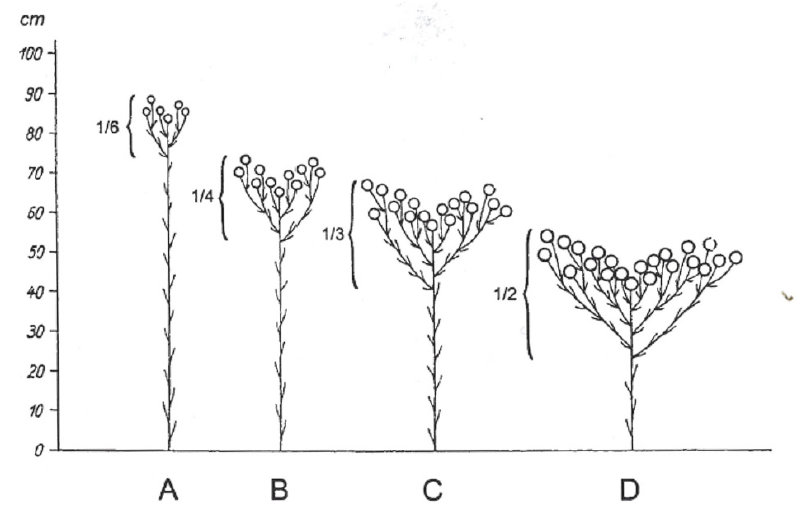
Figure 2. Technical stem length ranges occurring in flax; the part of the stem without side branches defines the technical stem length. The proportion of the stem with branches is indicated. ( A ) Typical fiber flax; ( B ) and ( C ) intermediate flax; and ( D ) large-seeded flax. (Figure and caption adapted from Diederichsen and Richards, (2003)) [38].